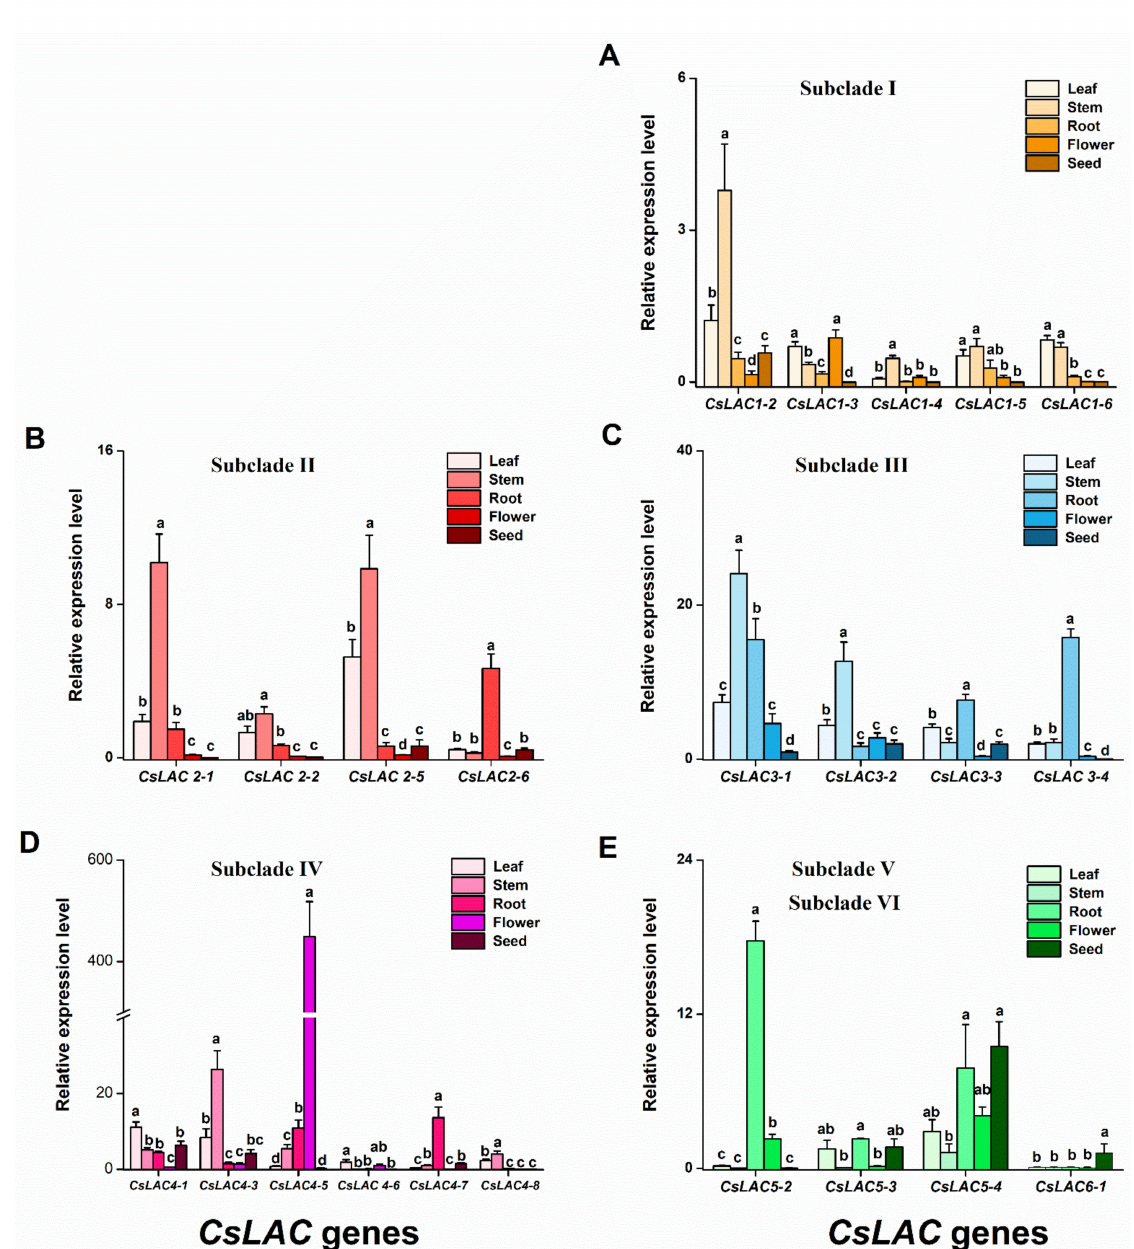
Figure 6. Transcript levels of CsLAC s in leave, stem, root, flower and seed of C. sinensis cv ‘Longjing43 (cid:48) cultivars. The relative expression level of CsLAC s from subclades I ( A ), II ( B ), III ( C ), IV ( D ) and subclades V and VI ( E ). Results are expressed as mean +SE ( n = 6). Different letters indicate significant differences among tissues ( p < 0.05, Turkey’s honest significant difference (HSD) post-hoc